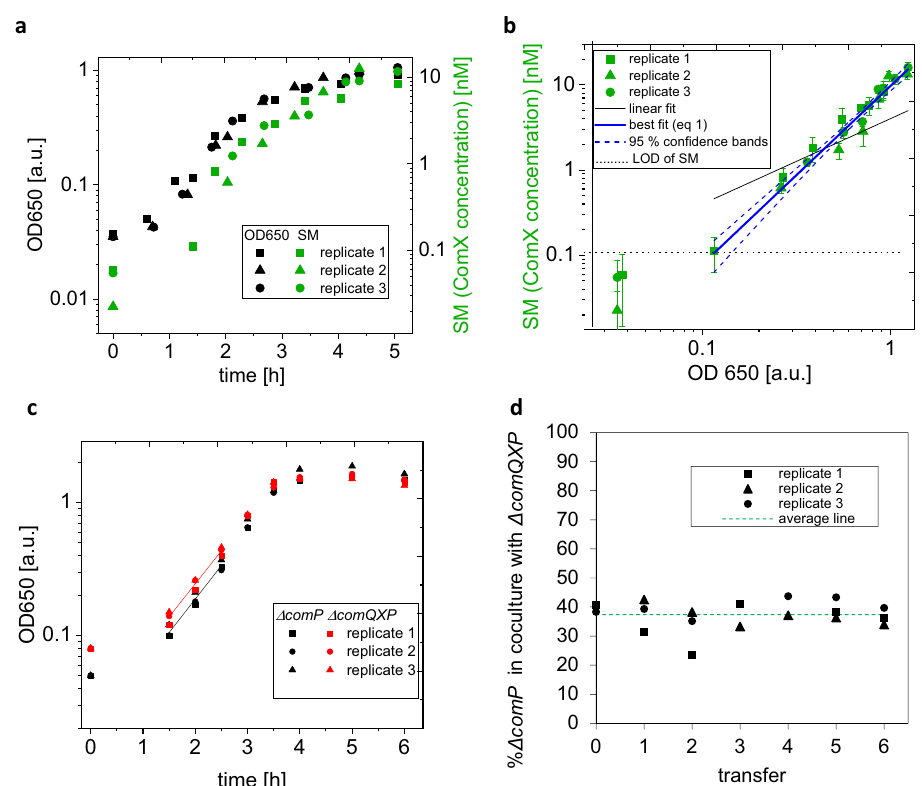
Fig. 2 The accumulation of signal molecule (SM) during the growth of B. subtilis and fi tness cost of SM production. a The growth curve (OD650) of B. subtilis PS-216 Δ comP (no signal receptor) producing SM (ComX) that is accumulating in the growth medium of fermenter working in the batch mode of n = 3 biologically independent replicates is presented; b The experimental data n = 3 biologically independent replicates where the data ≥ limit of detection of SM was fi tted by Eq. (1); the error bars for SM concertation are standard errors calculated from 8 technical replicates for each biological replicate; c The comparison of growth curves of B. subtilis PS-216 with no signal molecule receptor ( Δ comP ) and no signal molecule production and receptor ( Δ comQXP ) of n = 3 biologically independent replicates; the OD650 at t = 0 h was corrected with respect to the measured CFU of the inoculum. The slopes of the fi tted lines in c correspond to the growth rate divided by log 2; the exponential phase points in the most reliable OD650 region (>0.1 a.u. and <0.7 a.u.) were considered. The slopes do not differ signi fi cantly ( P = 0.32): Δ comP = (0.496 ± 0.007) h ‒ 1 and Δ comQXP = (0.503± 0.008) h ‒ 1 . d The same strains grown in co-culture; each time OD650 reached 0.6 a.u. the co-culture was transferred to the fresh medium; n = 3 biologically independent experiments were performed and each time 6 of 7 transfers were checked for CFUs of both